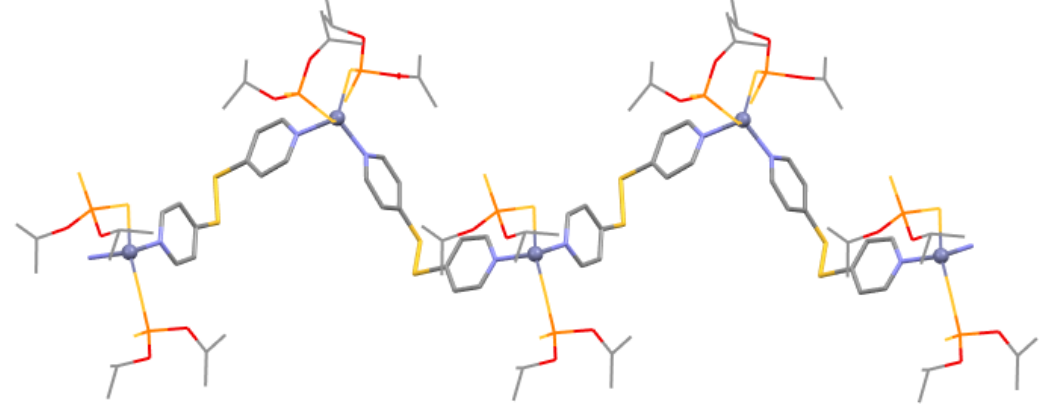
H O S ) ( μ - dtdp )] 6 14 2 2 2